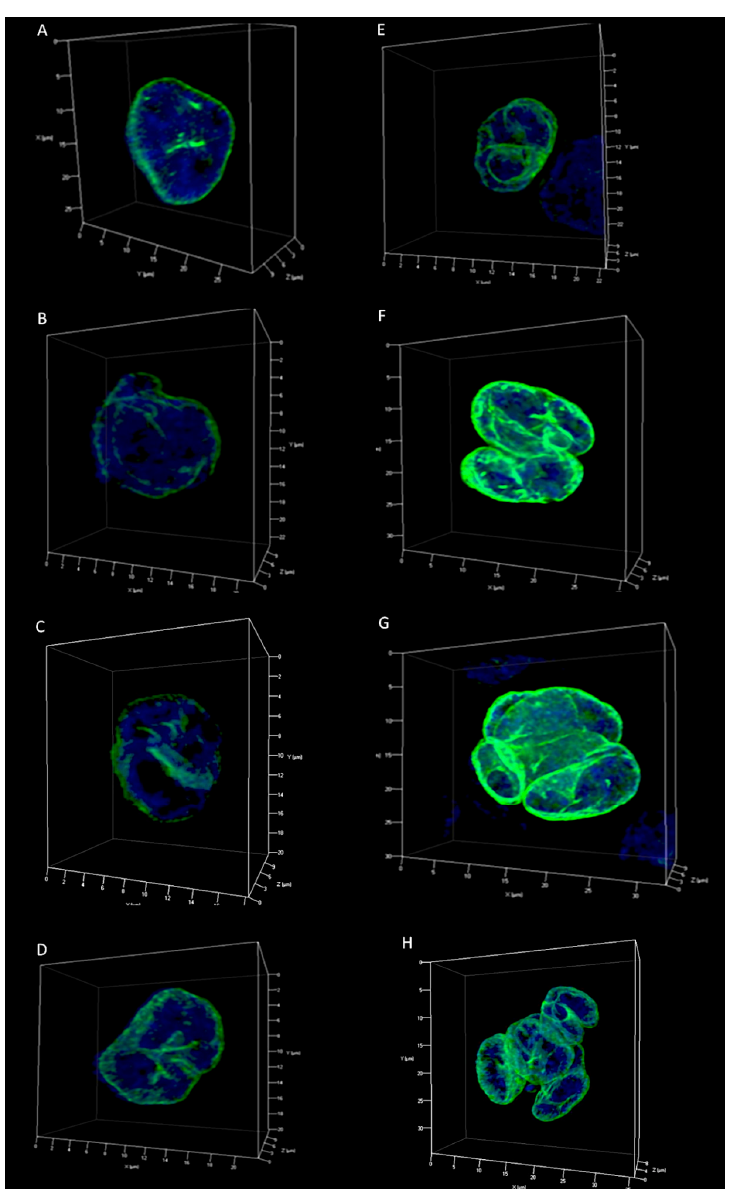
Figure 3. Lamin A/C patterns in 3D reconstructions of H and RS nuclei from HDLM-2. ( A – E ) H cells patterns according to how the internal lamin structures divide the 3D structure of lamin